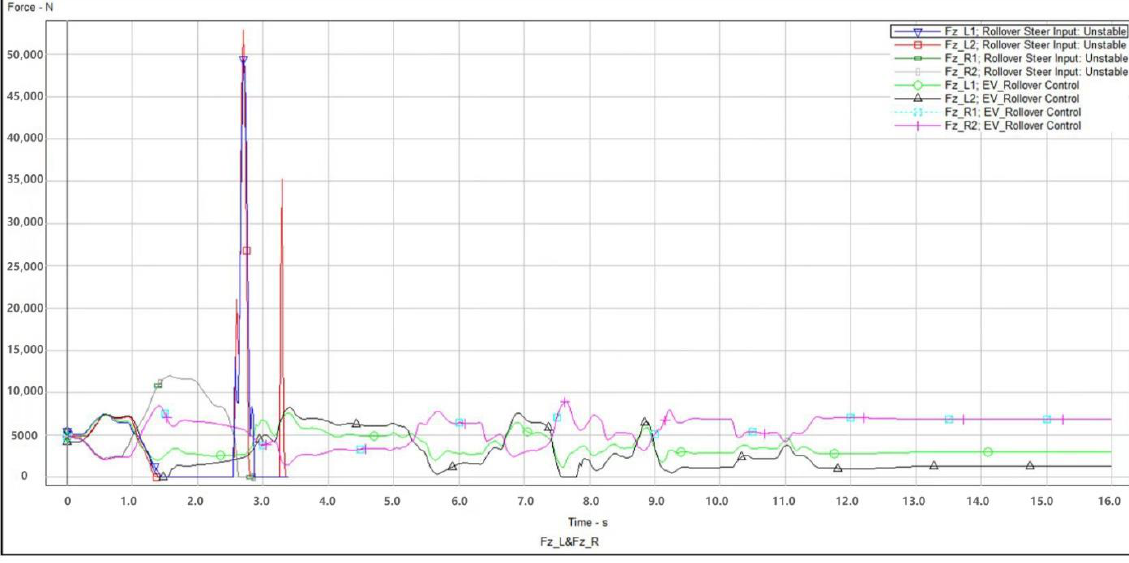
Figure 14. Wheel vertical load comparison curve for double lane-change test.